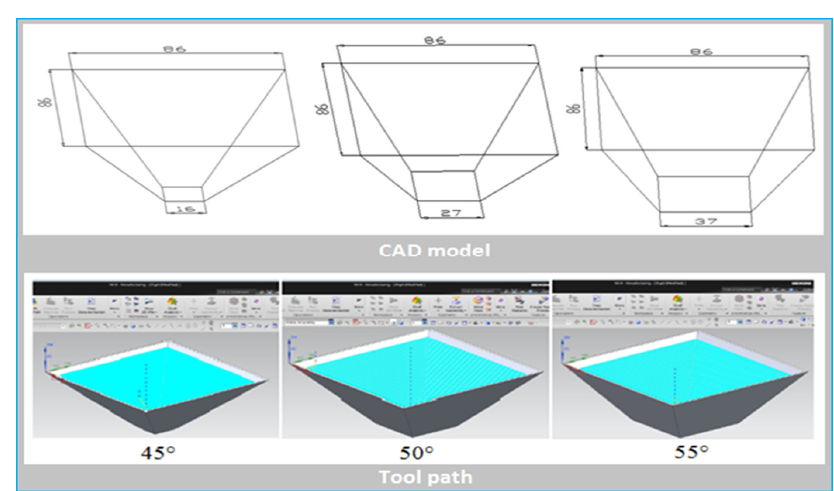
Fig. 3. The CAD geometry and tool path of